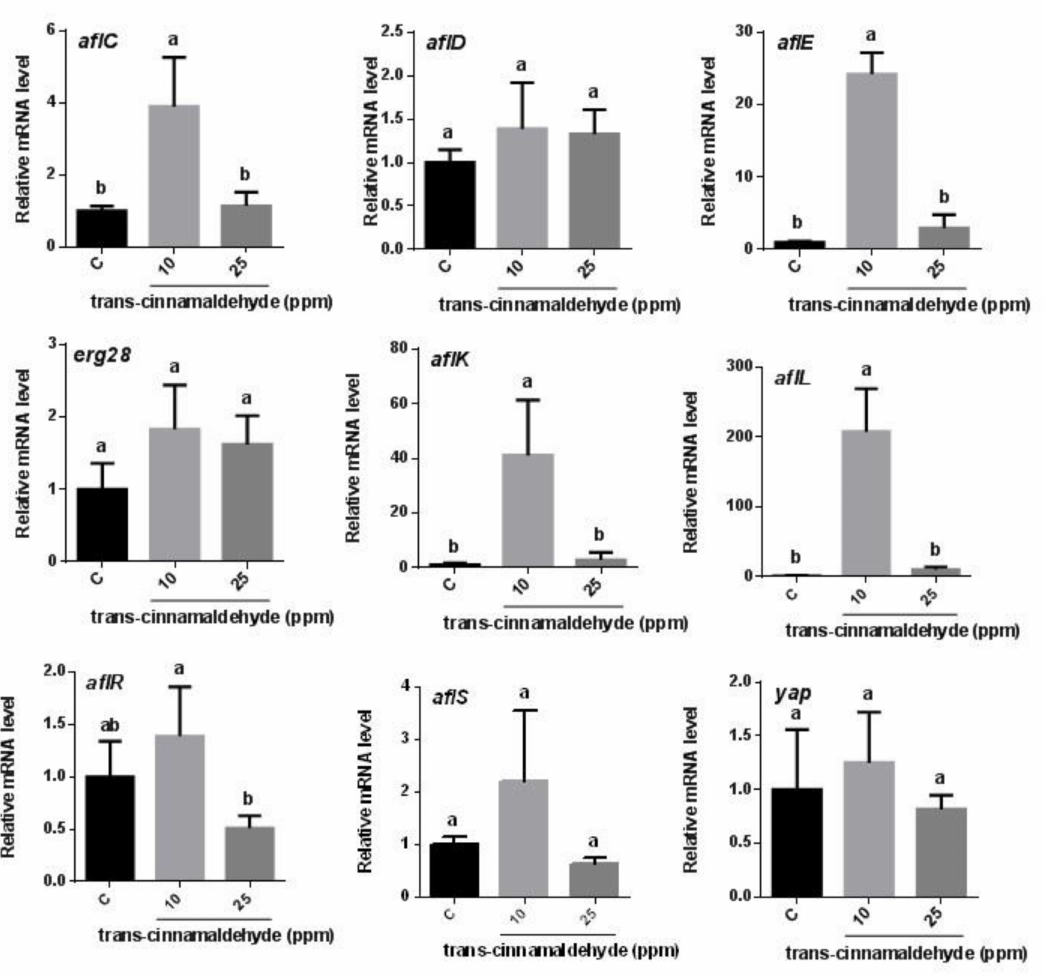
Figure 5. Expression of genes ( aflC , aflD , aflE , aflK , aflL , aflO , aflP , aflR , aflS , and yap ) involved in aflatoxin biosynthesis in Aspergillus flavus treated with t -cinnamaldehyde. An ergosterol biosynthetic gene, erg28 , was comparatively measured after treatment with t -cinnamaldehyde. Different letters above the same column indicate significant differences from the control group ( p <